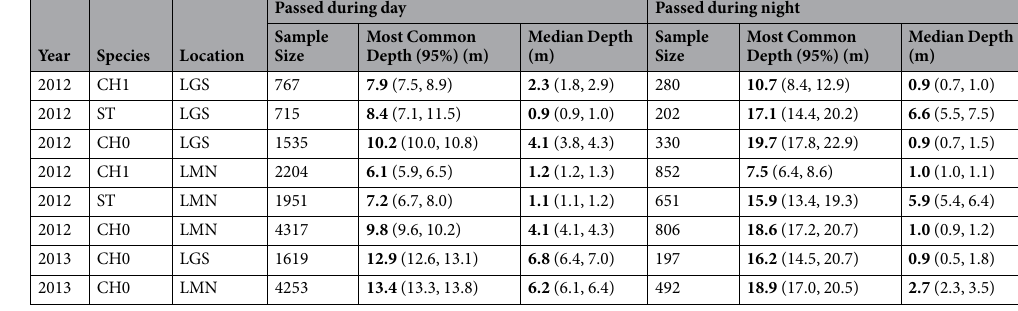
Table 3. Median depth during day and night at which three types of juvenile salmonids passed spillway routes were detected within the forebay of LGS and LMN during 2012 and 2013. 95% CI are listed in parentheses. The depth at which 95% of the fish were found at or were shallower than is also shown. All of the comparisons of depth distribution between day-passed and night-passed were significantly different (P < 0.001). CH0 = subyearling Chinook salmon; CH1 = yearling Chinook salmon; ST =